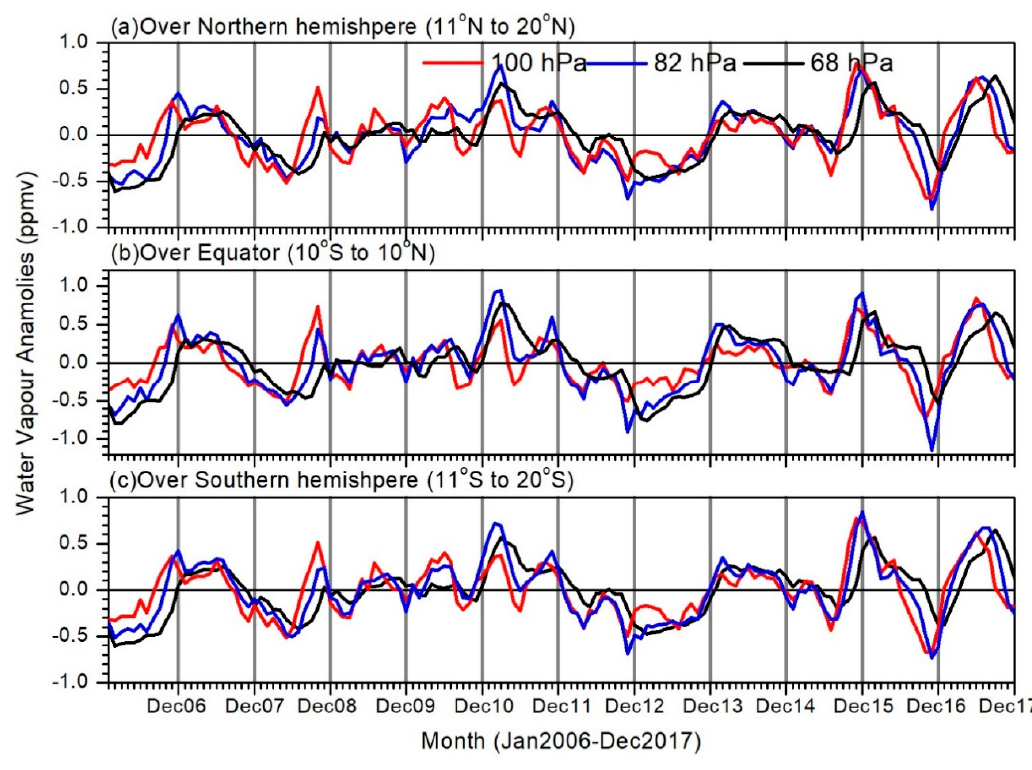
Figure 10. Zonal mean water vapour anomalies observed ( a ) over northern hemisphere (averaged over 11°N–20°N) ( b ) over equator (averaged over 10°N–10°S) and ( c ) over southern hemisphere (averaged over11°S–20°S). Different colours indicate different pressure levels.